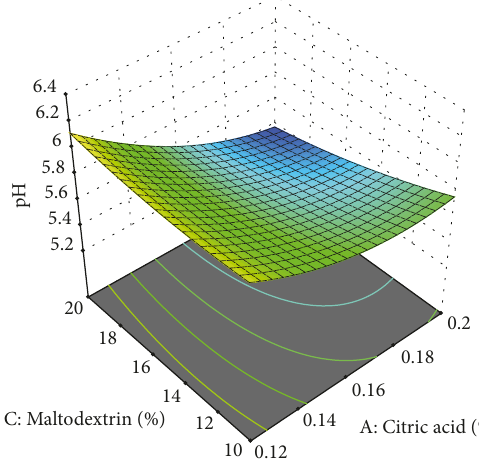
Figure 2: pH of cheese analogue from sweet corn extract was affected by concentration of citric acid and maltodextrin.